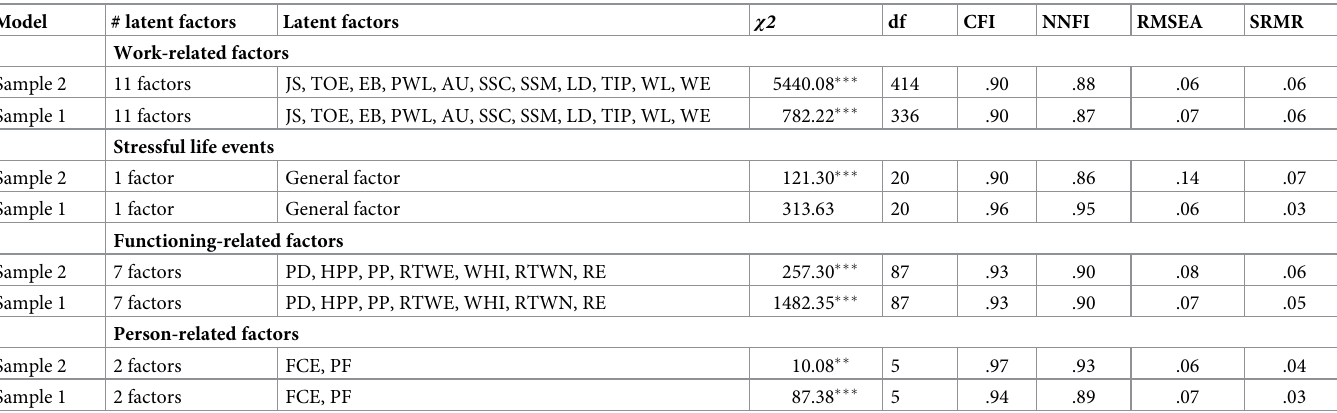
Table 3. Main results of confirmatory factor analysis: Latent factors fit indices and a model comparison for sample 1 (n = 3540) and sample 2 (n =